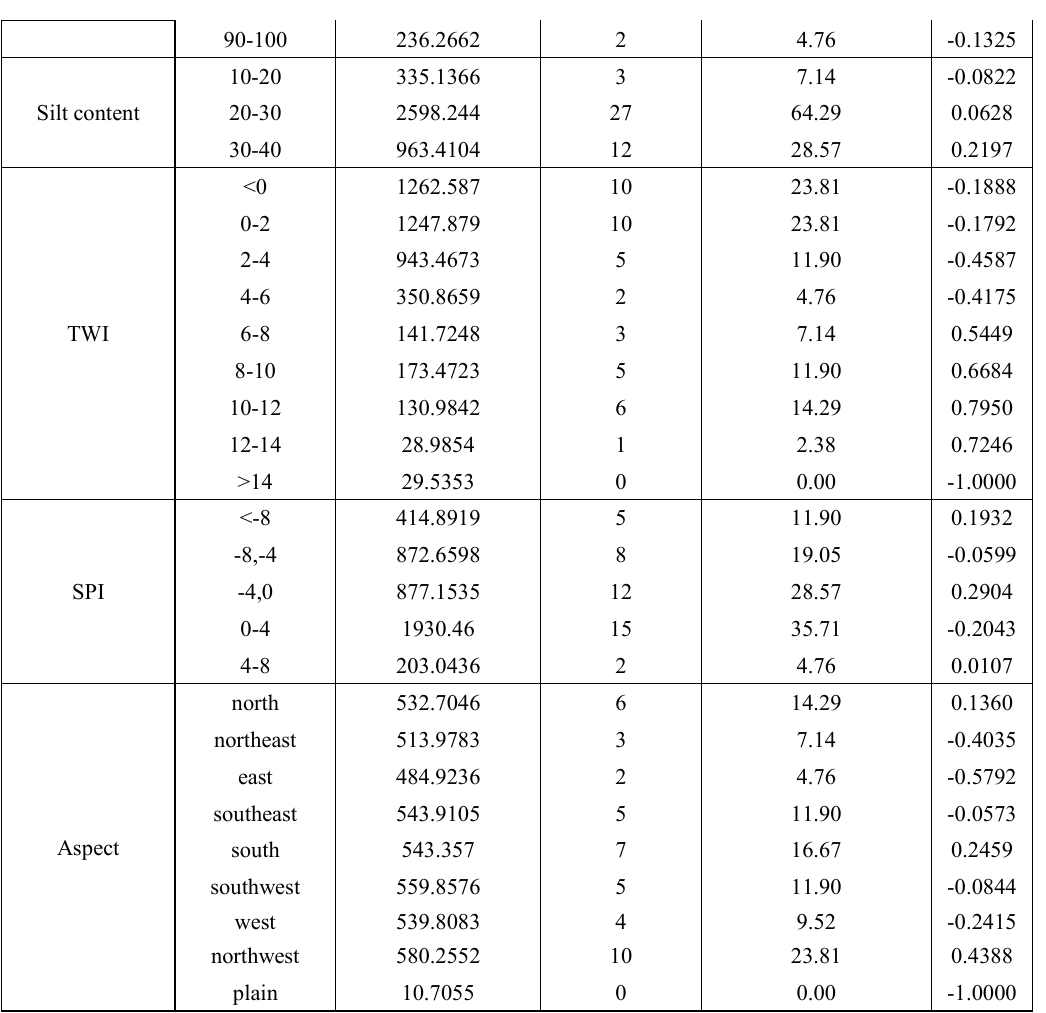
Table 1 . CF values of 10 disaster-causing factor classification levels.